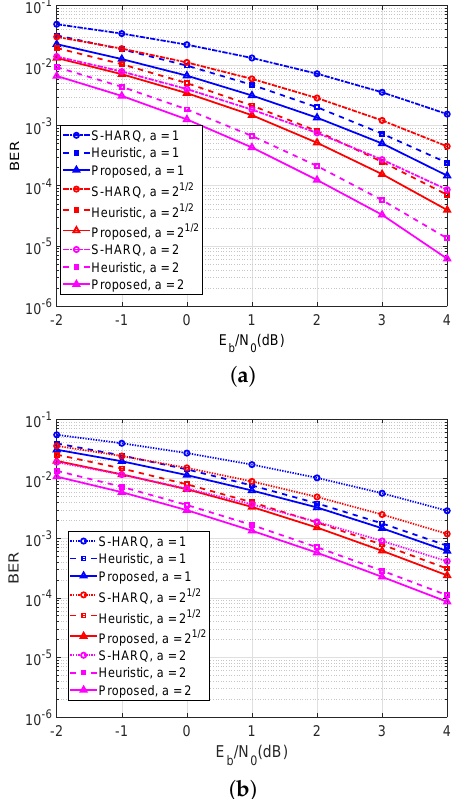
Figure 3. Monte-Carlo simulated BER of (1) quadratic assignment problem-optimized modulation diversity (2) λ 1 = λ 2 = λ S (3) λ 1 = λ 2 = λ 0 for K = 5,10, a = 1,